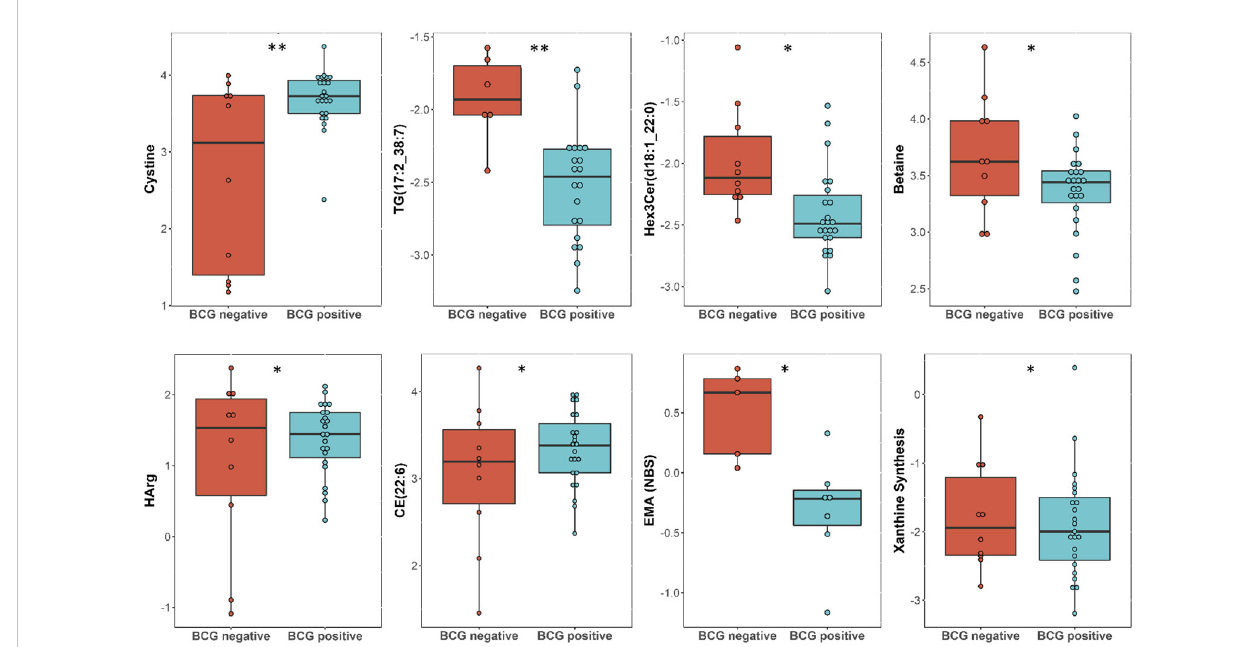
FIGURE 4 Metabolites associated with BCG vaccination in non-T2D patients with different levels of COVID-19 severity. **/* signi fi es <0.01/<0.05 p